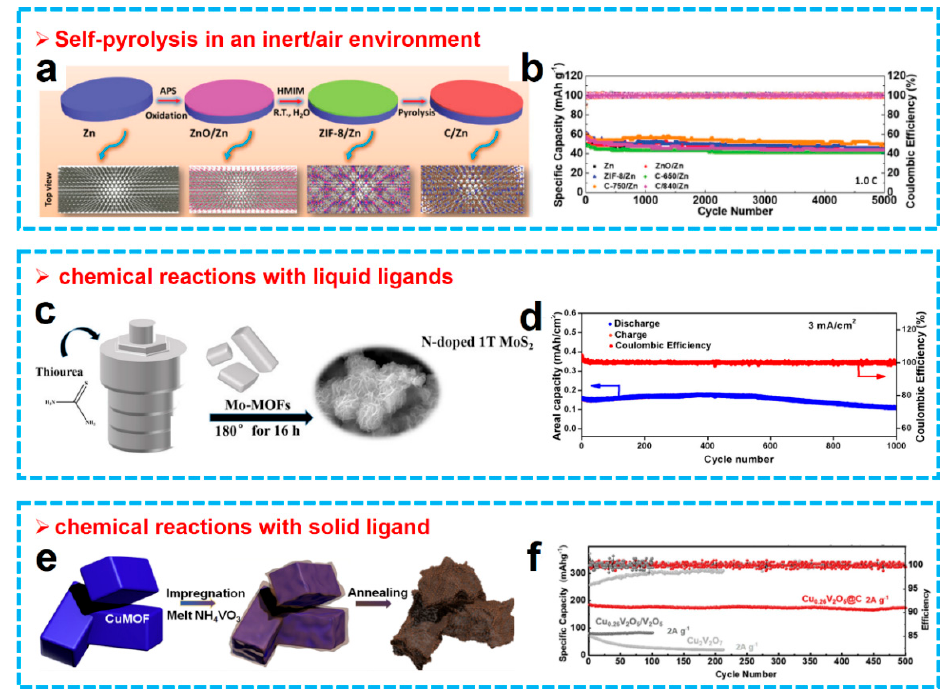
Figure 3. ( a ) Schematic of the fabrication process and the predicted top and side views of the Zn anode. ( b ) Cycling performance of the ZIB at 1.0 C Reproduced with permission from reference [48]. ( c ) Illustration of the preparation process of N-Doped 1T MoS 2 . ( d ) Long-term cycle performance at 3 mA cm − 2 with mass loading of 1.897 mg cm − 2 Reproduced with permission from reference [49]. ( e ) The schematic diagram of the melt-infiltration fabrication strategy for Cu 0.26 V 2 O 5 @C. ( f ) the cycling performance under 2 A g − 1 Reproduced with permission from reference.